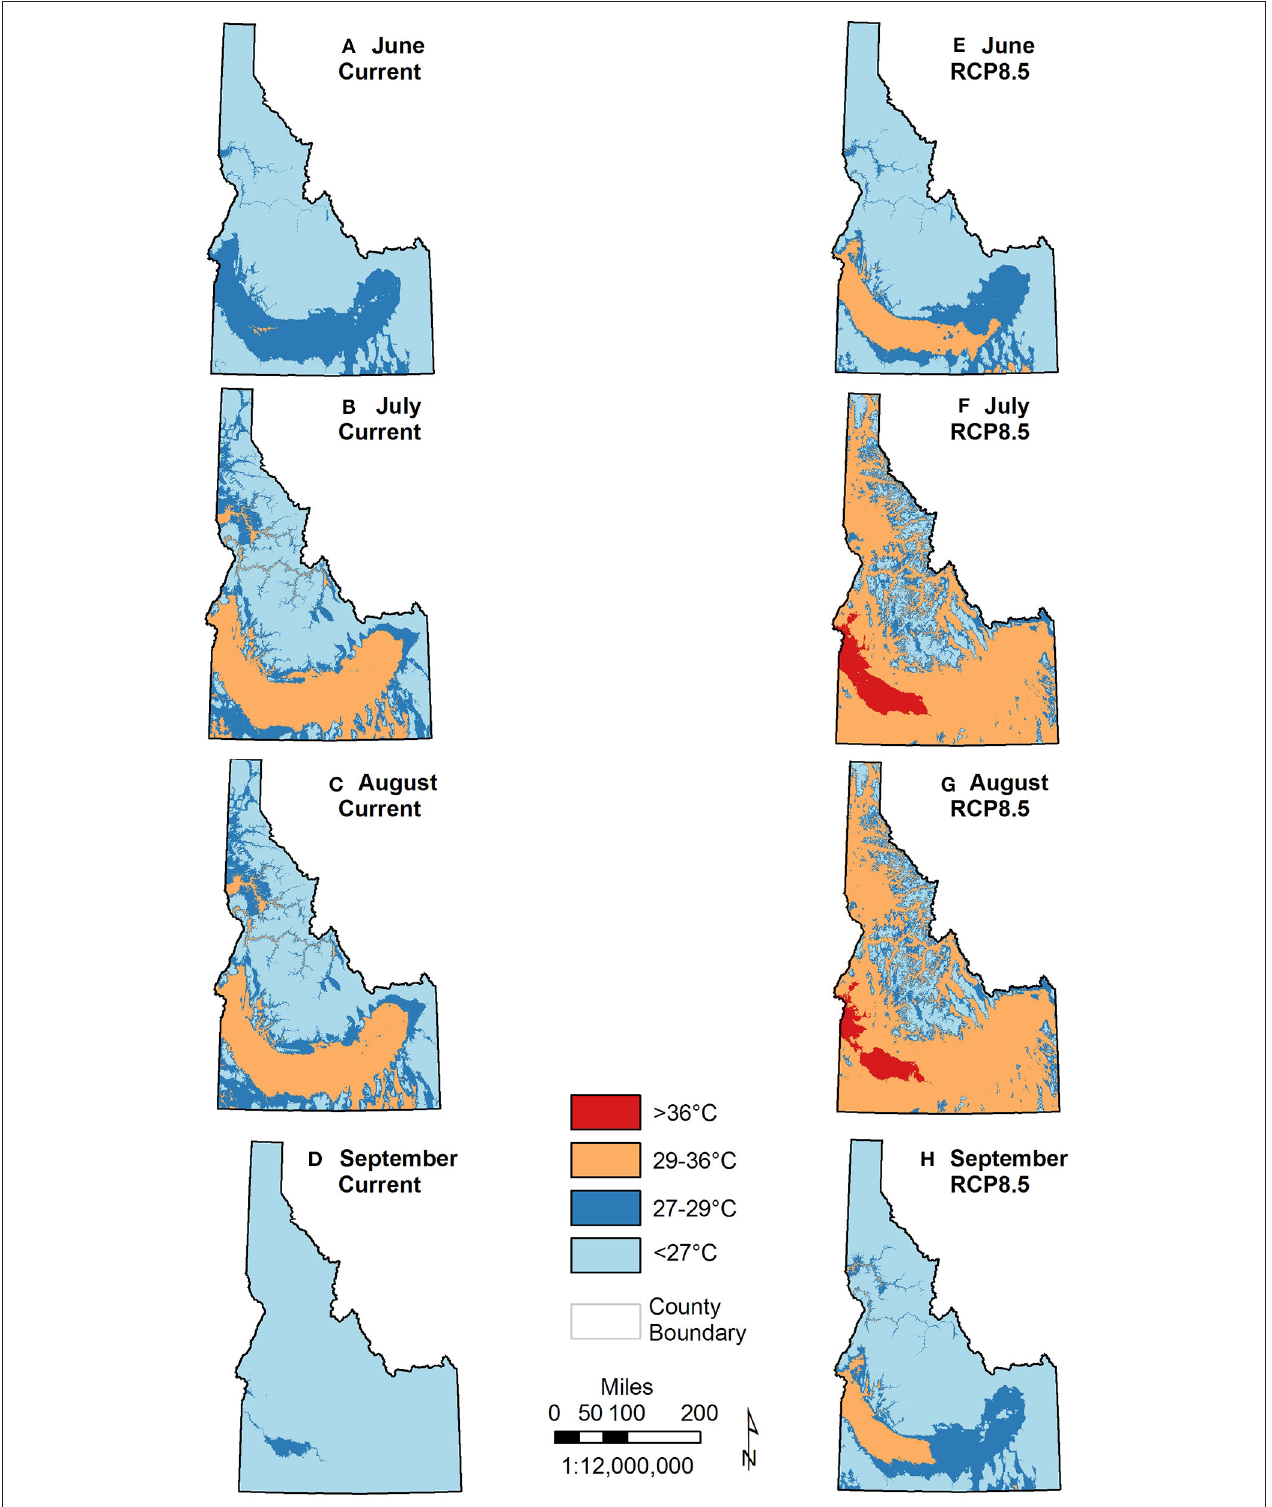
FIGURE 8 | Extent of optimal and lethal maximum temperatures for monarchs based on derived maximum monthly temperatures for current (1980-2010) and projected mid-century under RCP8.5 in June (A,E) , July (B,F) , August (C,G) , and September (D,H) .